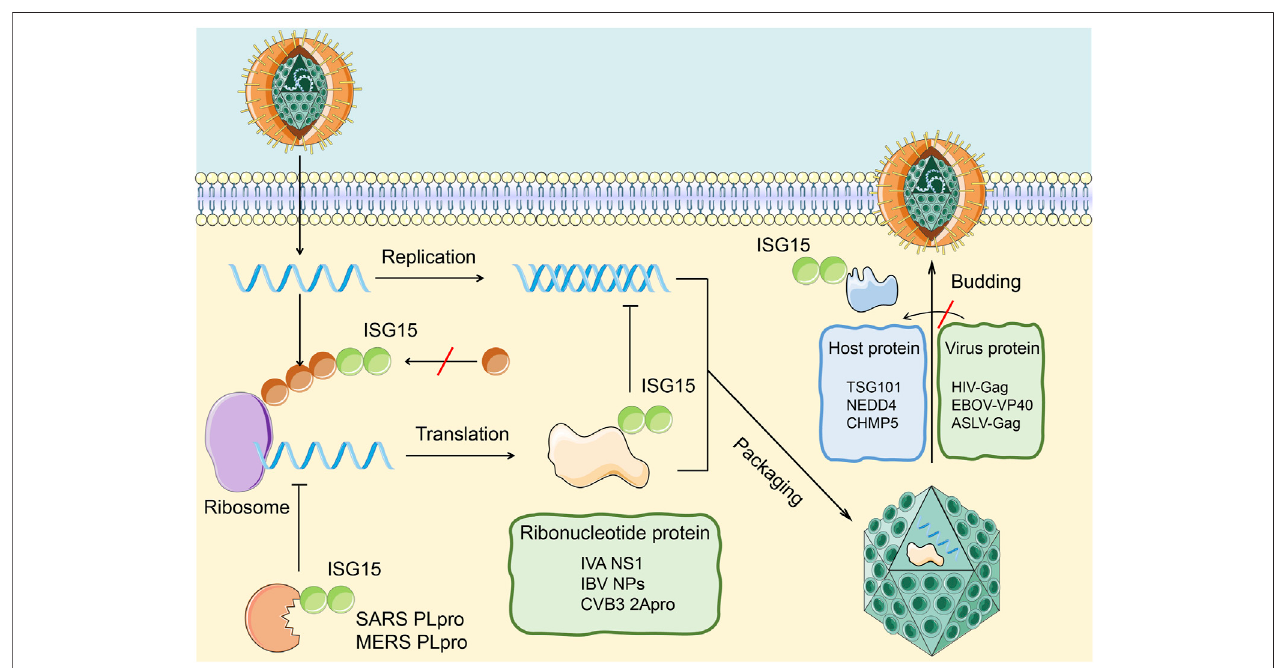
FIGURE3| Antiviraleffects ofISGylationonhostand viralproteins. ISG15affects theinfectionofcellsbythevirusthroughcovalently bindingwithviralproteinsand host proteins. 1. The combination of ISG15 and the viral nucleoprotein (green) can destroy the protein oligomerization and the ability of the viral nucleoprotein to inhibit virus replication. The ubiquitin-like modi fi cation formed by this combination can be cleaved by PLpro to restore the replication ability of the virus.2. The combination of ISG15 and host protein (blue) can inhibit the interaction between host protein and virus protein, thereby inhibiting the release of virus particles in the cell.